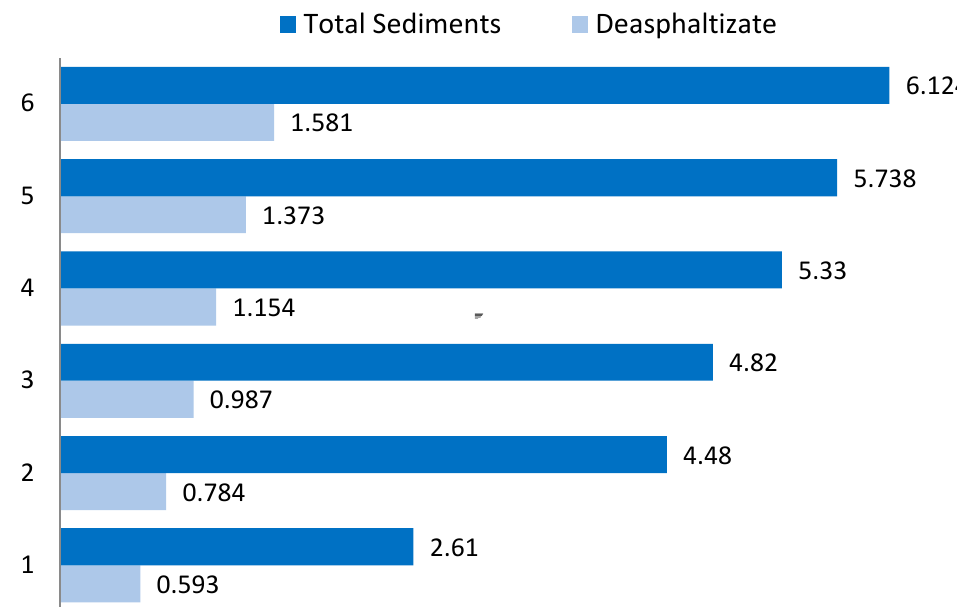
Figure 4. Sulphur content in total sediments and deasphaltisation.